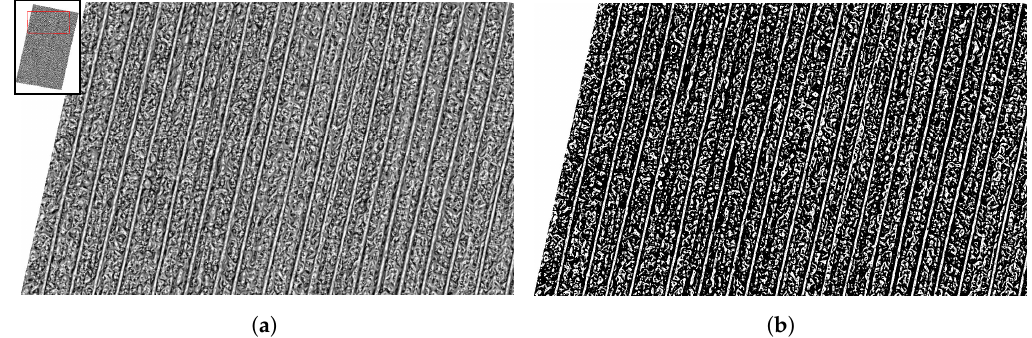
Figure 8. Binary image before ( a ) and after ( b ) threshold segmentation. Partial location is displayed in the left upper corner in Figure 8a. Ridge candidates are valued as 1 in white and non-ridge candidates are valued as 0 in black.